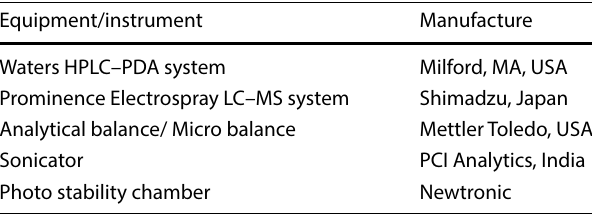
Table 1 Equipment/instrument details